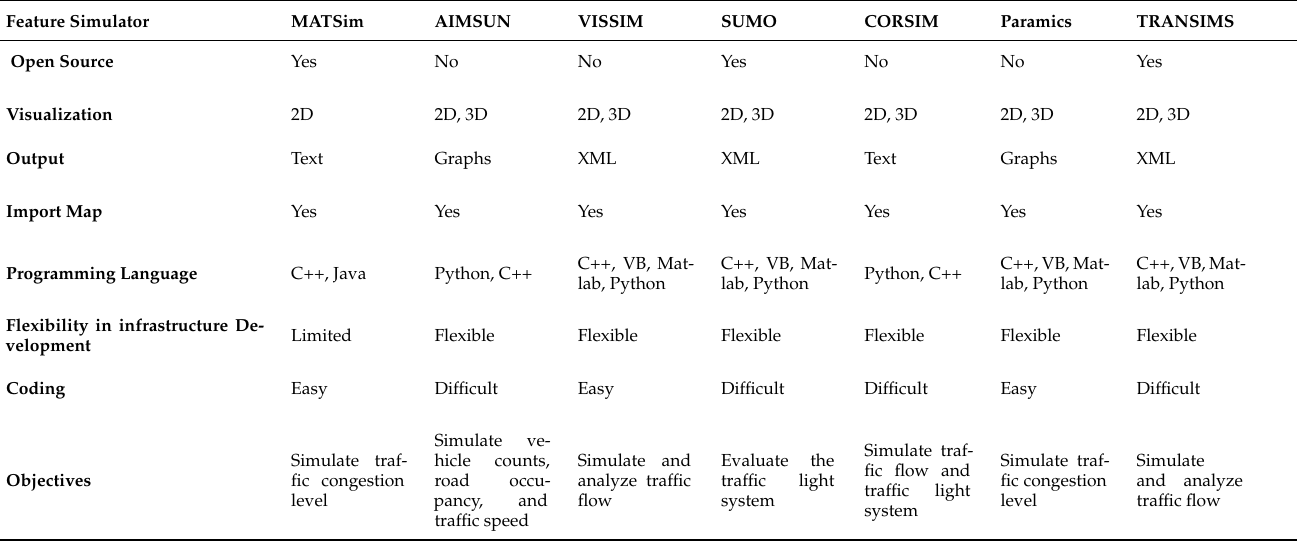
Table 2. Different traffic simulation tools and their main features and